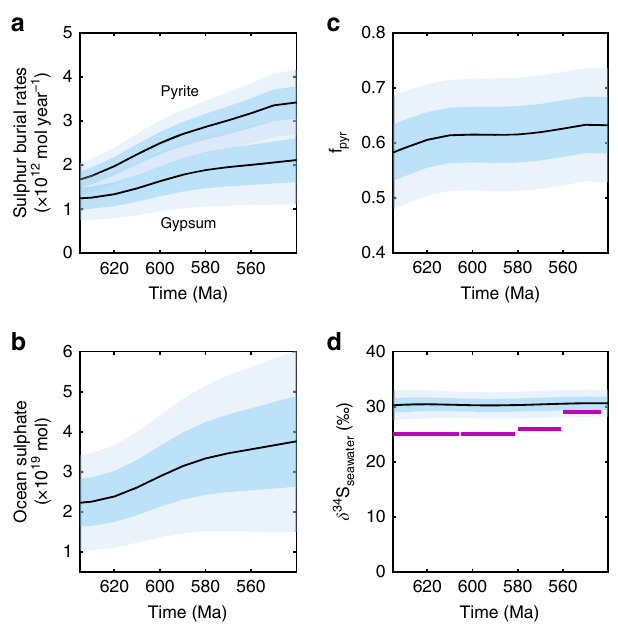
Fig. 7 Sulphur cycle outputs. a Sulphur burial rates. b Ocean sulphate concentration, c f py , d δ 34 S of seawater. Light shaded windows show ± 1 std. dev, dark shaded windows show± 0.5 std. dev. Geologic data in